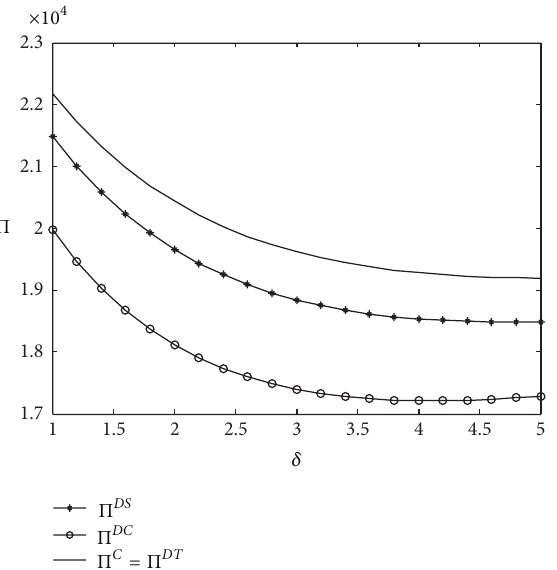
Figure 11: Impact of 𝛿 on supply chain